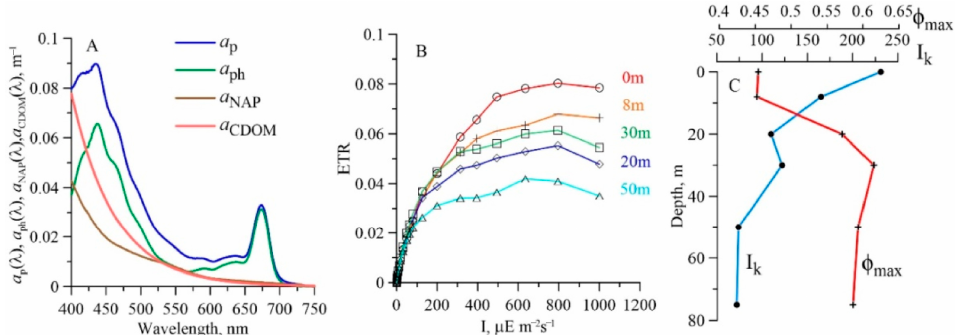
Figure 10. Examples of spectral light absorption coefficients of particles ( a p ( λ ), m − 1 ), non-algal particles ( a NAP ( λ )), phytoplankton a ph ( λ ), and colored dissolved organic matter( a CDOM ( λ )) ( A ); Light curves of relative electron transport rate (ETR, rel. un.) ( B ); Vertical distribution of the saturating light intensity (I k , µE m − 2 s − 1 , blue line) and maximum quantum yield of photosynthesis ( ϕ max, C quantum − 1 , red line) ( C ).